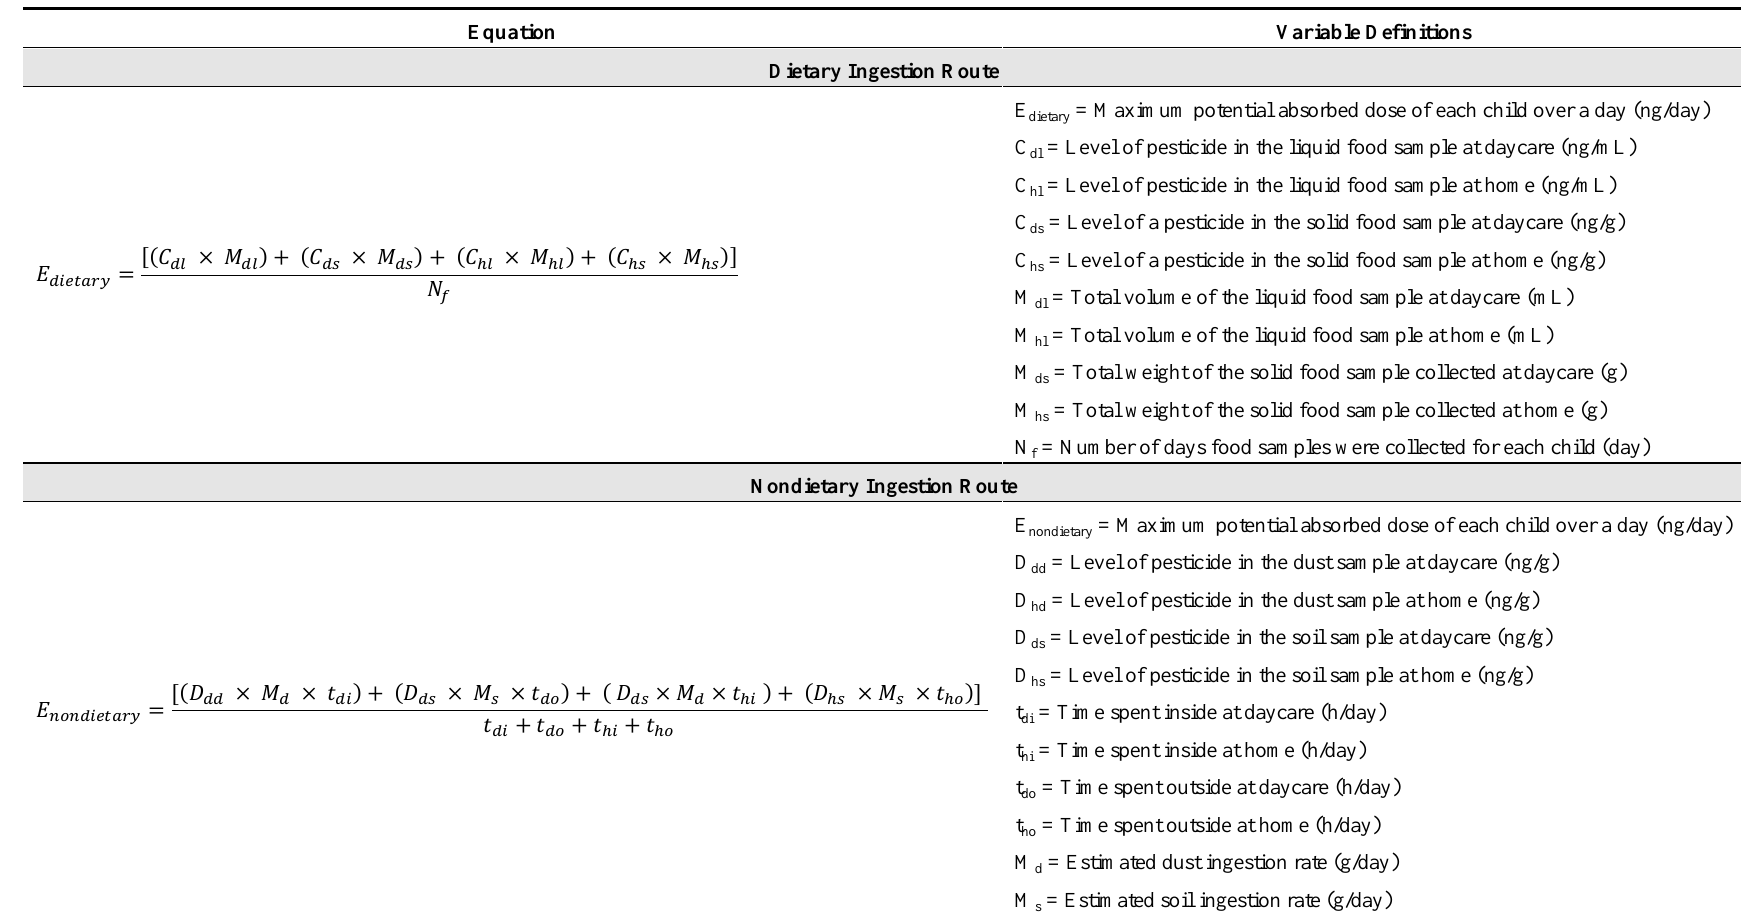
Table 2. Equations used to calculate the children’s estimated potential exposures to a pesticide by the dietary, nondietary, and inhalation exposure routes a,b